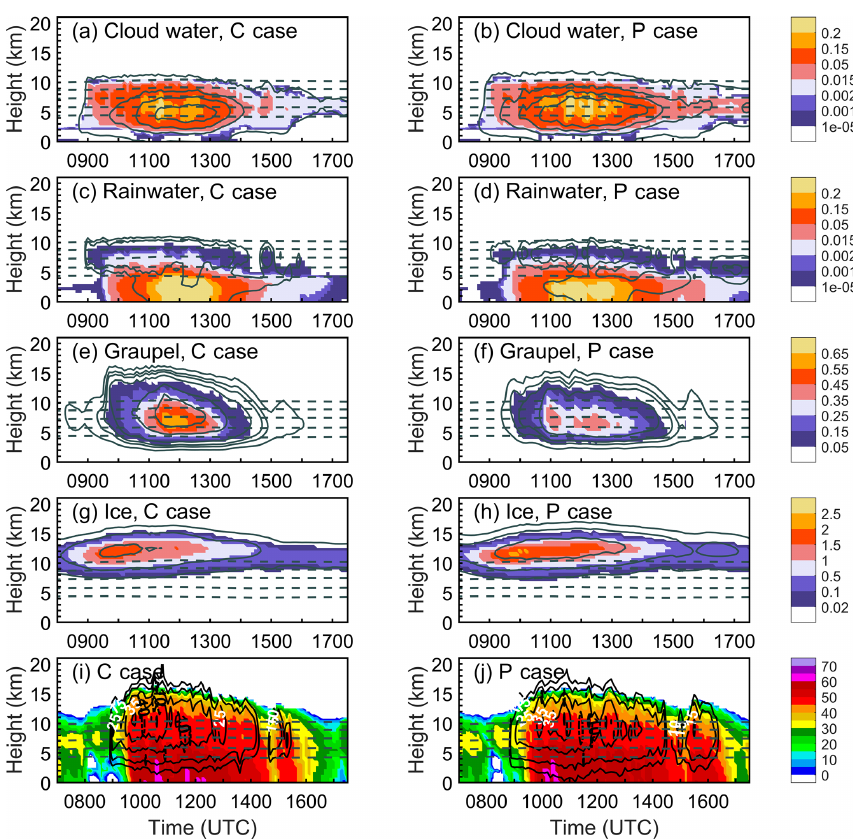
Figure 10. (a–h) Temporal variation in the vertical profiles of the domain-averaged mass mixing ratio (gkg − 1 , shaded) and number con- centration (kg − 1 , solid lines) of (a) cloud water in the C case, (b) cloud water in the P case, (c) rainwater in the C case, (d) rainwater in the P case, (e) graupel in the C case, (f) graupel in the P case, (g) ice in the C case and (h) ice in the P case. Contour levels in (a–h) are 10 6 , 2 × 10 7 , 5 × 10 7 and 10 8 kg − 1 for the cloud water number concentration; 100 and 300kg − 1 for rainwater; 10, 30, 50, 100, 300, 500, 700 and 1000kg − 1 for graupel; and 0 . 1 × 10 7 , 1 × 10 7 and 5 × 10 7 kg − 1 for ice. (i–j) Time–height maximum simulated radar reflectivity (color shading, unit dBZ) and maximum vertical velocities (solid line and white label: 10, 15, 25, 35, 45ms − 1 ; dashed line and black label: − 10, − 15ms − 1 ) for (i) the C case and (j) the P case. The 0, − 10, − 20, − 30 and − 40 ◦ C isotherms are shown by the dashed gray lines in (a) – (j)